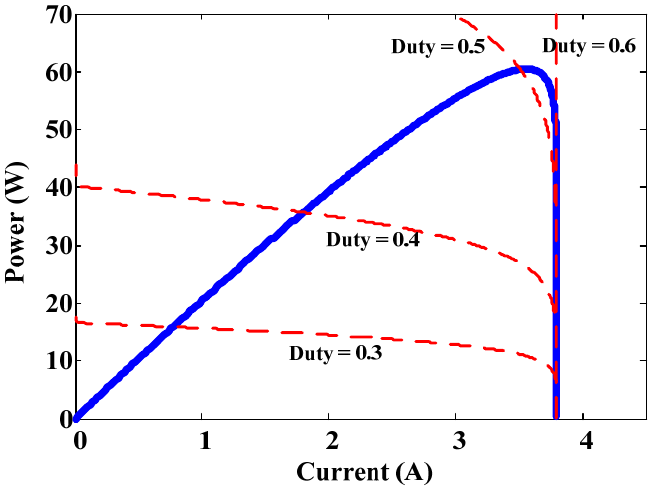
Figure 16. PV cell power-current characteristics.